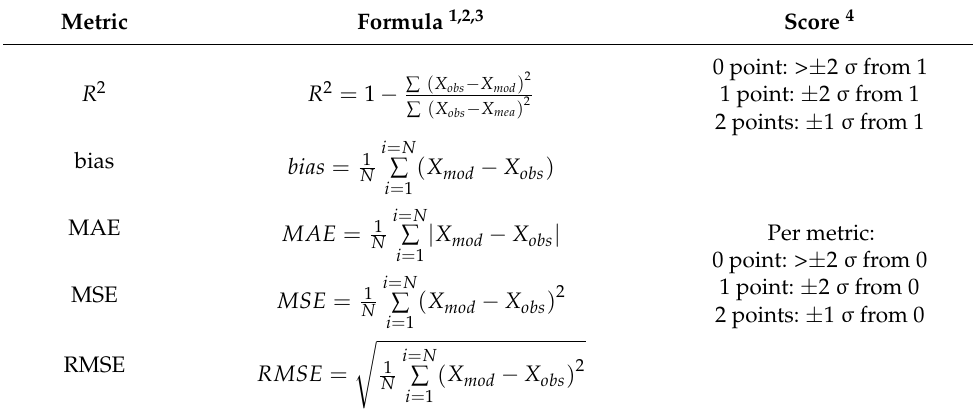
Table 4. List of statistical metrics.